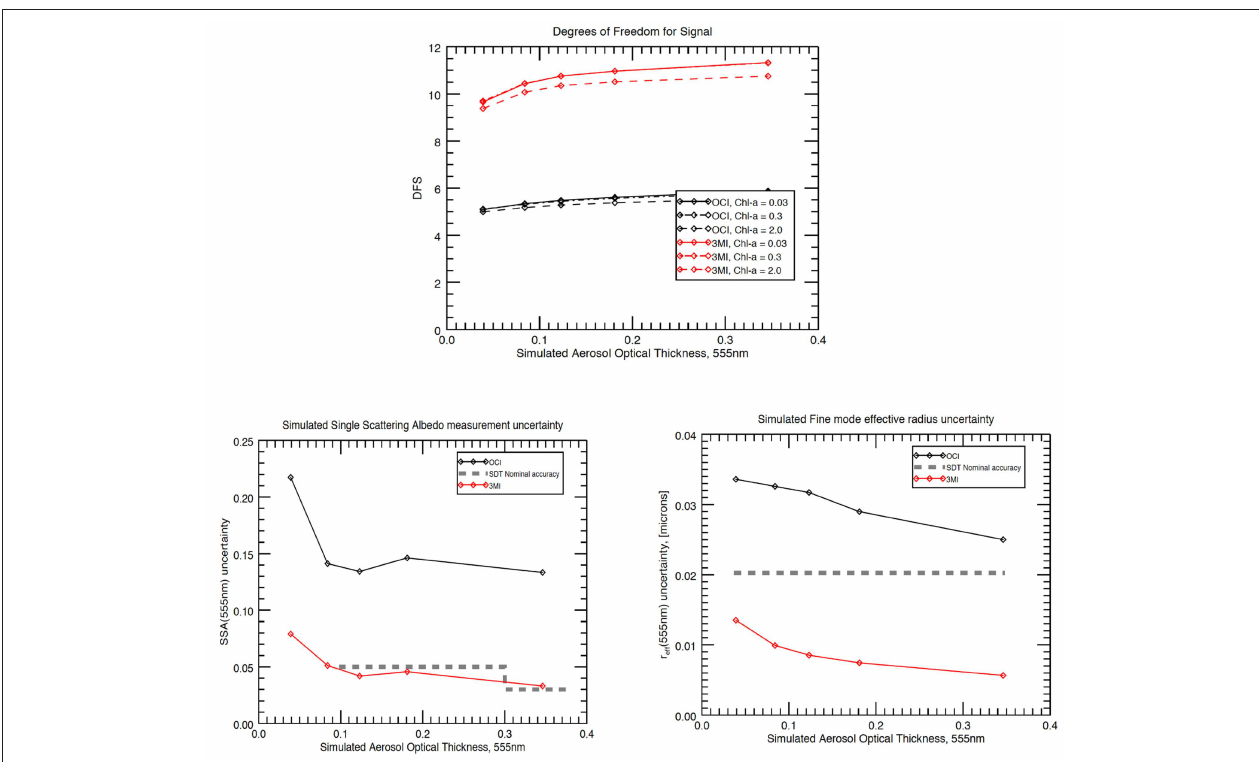
FIGURE 3 | (Top) Calculated degrees of freedom (information content) from OCI (black) and a multi-angle polarimeter, the European 3MI instrument (red), as function of calculated Aerosol Optical Thickness (AOT). The different lines represent different chlorophyll concentrations in the simulated ocean. Note that 3MI is used as a generic example of a MAP, and is not expected to fly on PACE. (Bottom) Calculated uncertainties in simultaneous retrievals of single scattering albedo (bottom left) and fine mode effective radius (bottom right) for the two instruments, following the same color scheme. The dashed line indicates the uncertainty requirements of these parameters, defined by the PACE Science Definition Team report ( NASA,